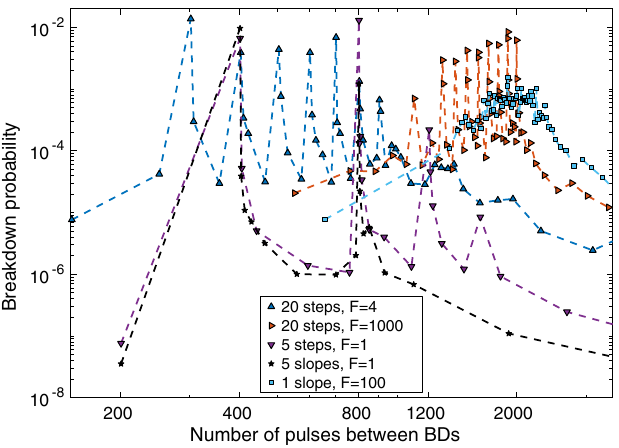
FIG. 9. Enlargement of Fig. 4 showing the breakdown prob- ability PDF against the number of pulses between breakdowns for the scenarios with 20 stairs, five stairs, five slopes, and one